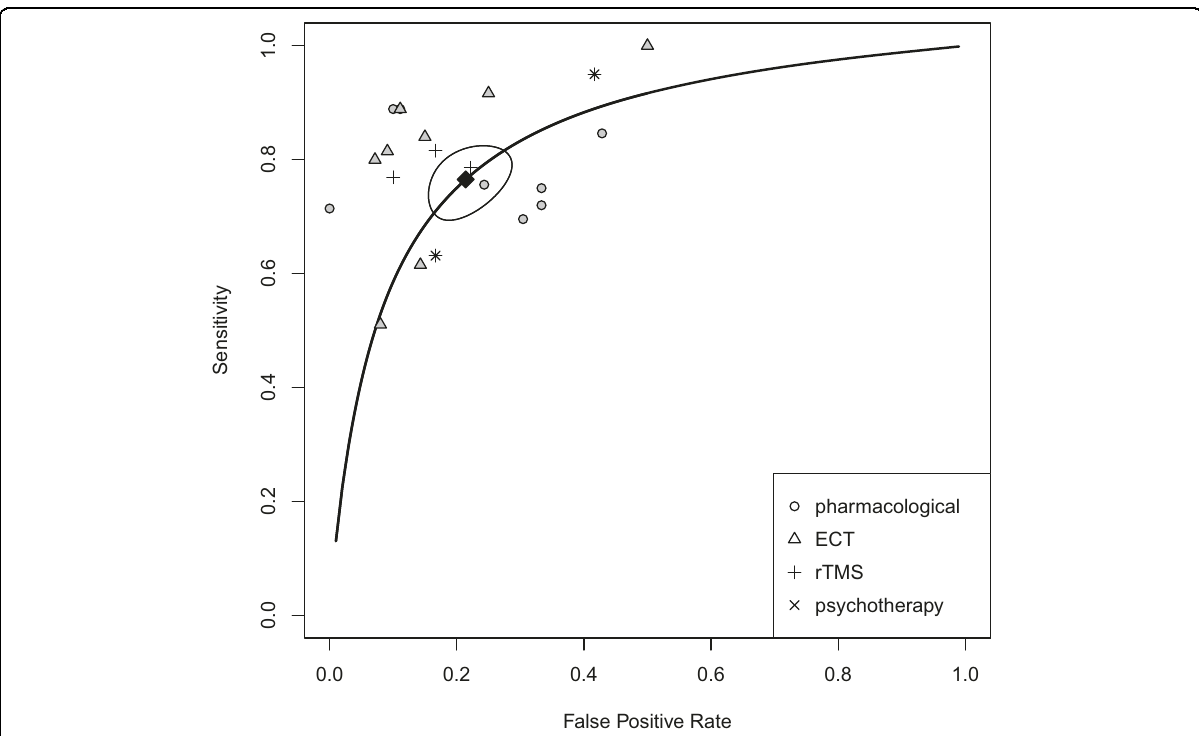
Fig. 2 Overall accuracy measures: area under the curve 0.84 (95% CI 0.81 – 0.87), sensitivity 77% (95% CI 71 – 82), speci fi city 79% (95% CI 73 – 84). Reitsma bivariate SROC model of the receiver operating characteristic curve. Summary of sensitivity and false-positive rate (1 − speci fi city) is indicated in black, sensitivity and false-positive rates for different interventions are gray-scale. ECT electroconvulsive therapy, rTMS repetitive transcranial magnetic stimulation, pharmacological pharmacotherapeutic antidepressive